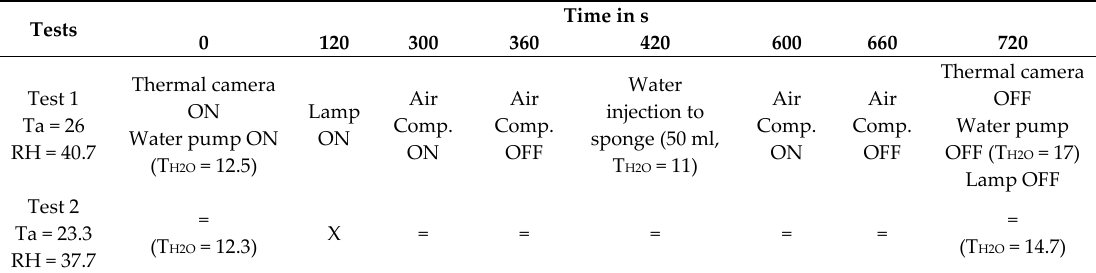
Table 1. Steps followed in the two experiments performed in this paper (“Ta” = ambient temperature (°C), “T H2O ” = water temperature (°C) and “RH” = relative humidity